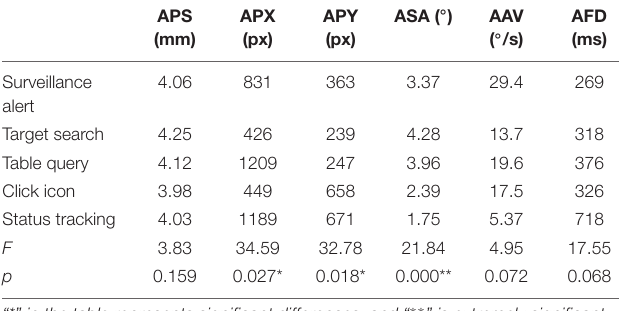
TABLE 1 | Analysis results of eye movement index